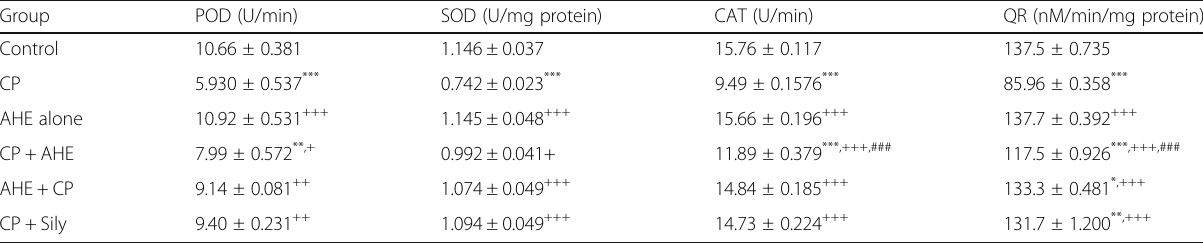
Table 3 Effect of cisplatin (CP) and different treatments of extract AHE on cardiac tissue antioxidant enzymes Group POD (U/min) SOD (U/mg